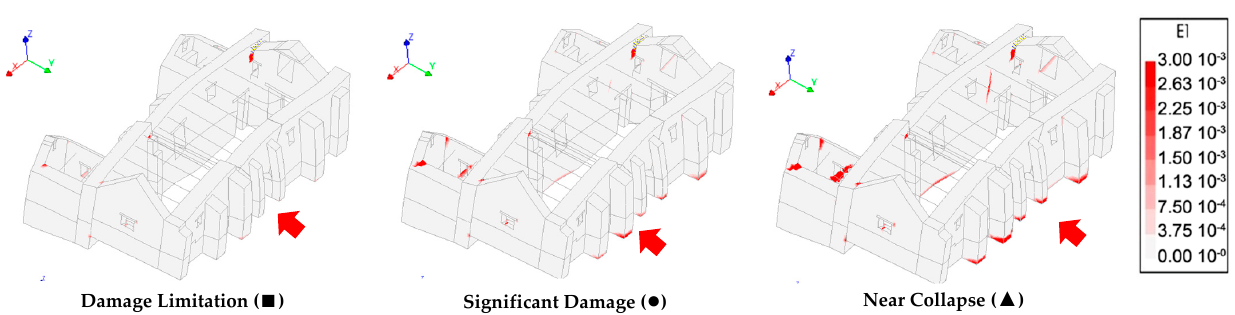
Figure 26. Damage Limitation (solid black line), Significant Damage (dotted black line) and Near Collapse (dash-dot black line) elastic demand spectra and bilinearized SDOF capacity diagrams indicating the target displacements ( ∎ , ● , ▲ ) in the − YY direction. The distribution of maximum principal plastic strains corresponding to the attainment of the target displacement at each performance level is shown in the contour diagrams.